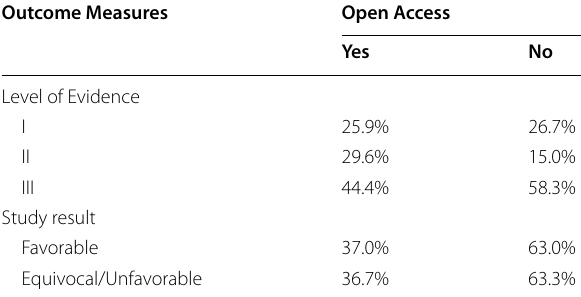
Table 4 Effect of open access on level of evidence and study